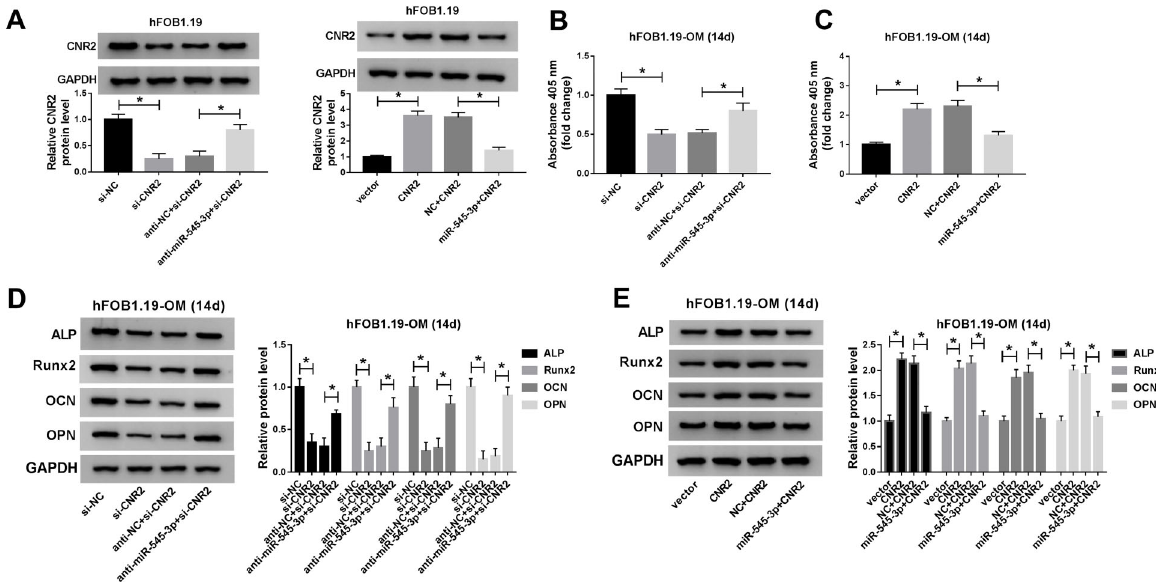
Figure 8. MiR-545-3p inversed the effect of CNR2 on osteogenic differentiation. A , The protein level of CNR2 was measured in hFOB1.19 cells transfected with si-NC (negative control), si-CNR2, anti-NC + si-CNR2, or anti-miR-545-3p + si-CNR2. Additionally, CNR2 expression was detected in hFOB1.19 cells introduced with vector, CNR2, NC + CNR2, or miR-545-3p + CNR2. B , ALP activity was determined in osteogenic differentiated hFOB1.19 cells transfected with si-CNR2 and/or anti-miR-545-3p. C , After introduction with CNR2 and/or miR-545-3p, ALP activity was evaluated in osteogenic differentiated hFOB1.19 cells. D , Protein levels of ALP, Runx2, osteocalcin (OCN), and osteopontin (OPN) were measured in osteogenic differentiated hFOB1.19 cells following CNR2 down-regulation and/or miR-545-3p down-regulation. E , Expression of ALP, Runx2, OCN, and OPN was detected in osteogenic differentiated hFOB1.19 cells following CNR2 overexpression and/or miR-545-3p overexpression. Data are reported as means ± SD of three independent experiments. *P o 0.05